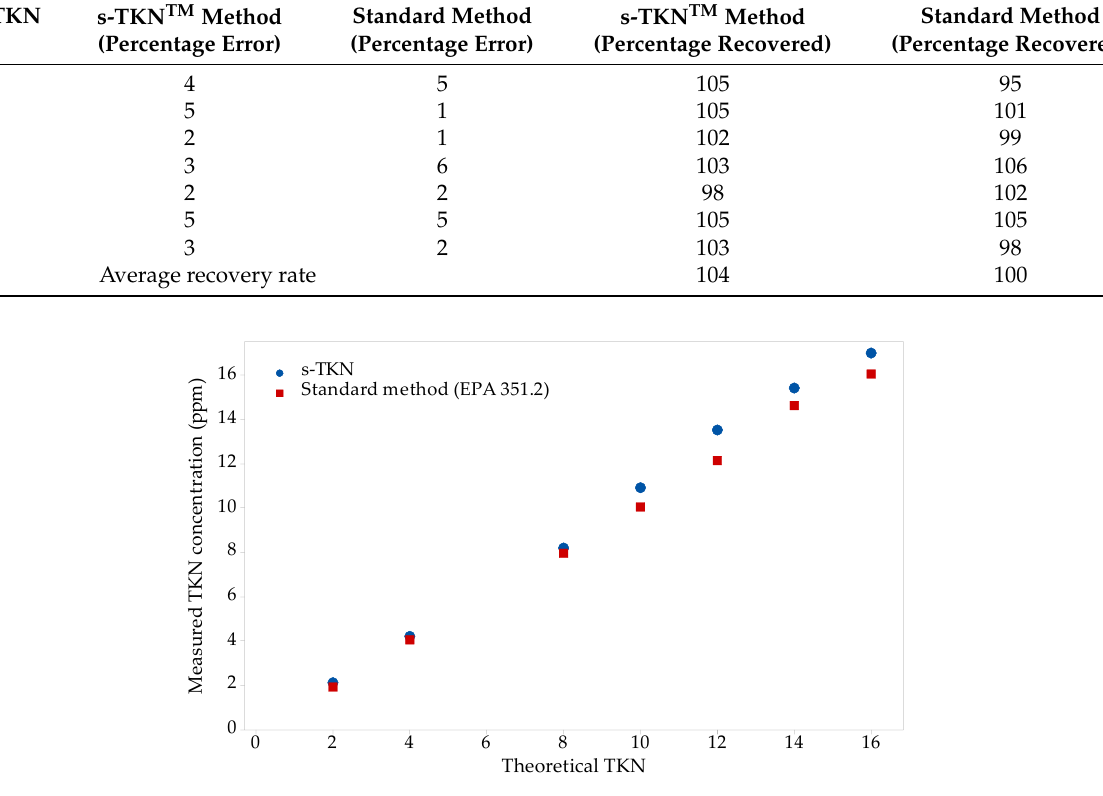
Figure 3. TKN concentrations in mixed standards of Gly-PTSA-nitrate analyzed using the s-TKN TM method and the standard method.